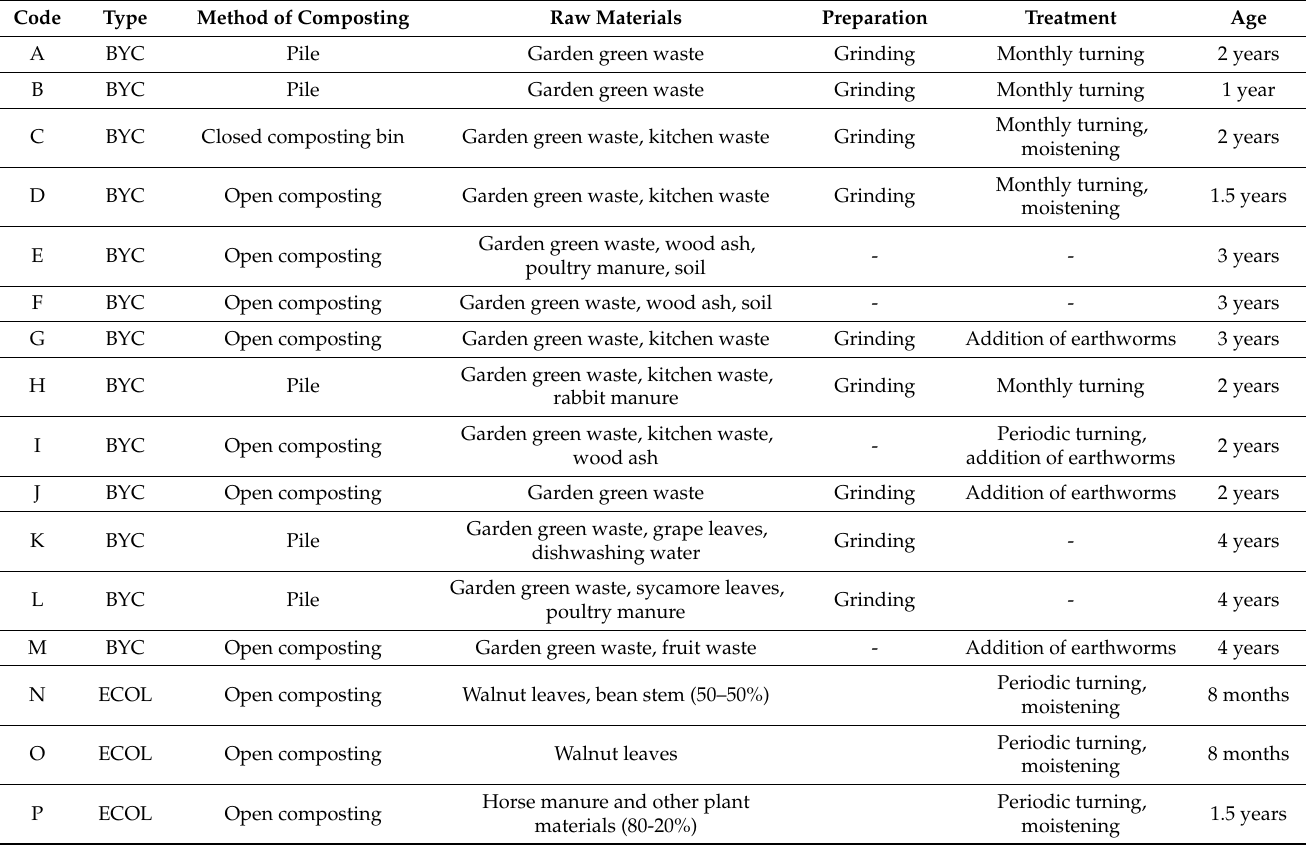
Table 1. The properties of the examined composts (BYC—backyard compost; ECOL—ecological farm).